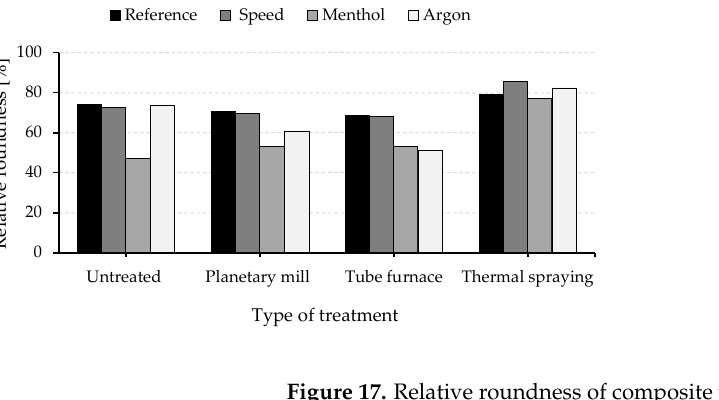
Figure 17. Relative roundness of composite powders produced with ( a ) different milling parameters and different post-treatments and ( b ) the influence of treatment temperature.